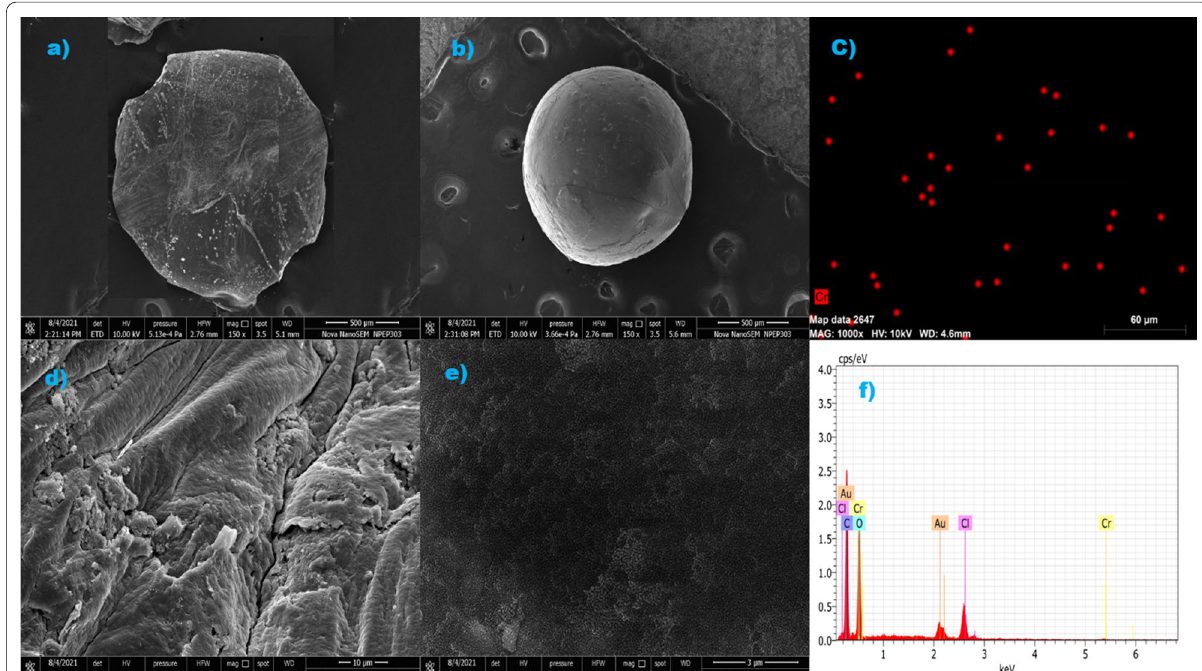
Fig. 2 a FESEM image of entire C bead. b FESEM image of entire C higher magnification. e FESEM image of C